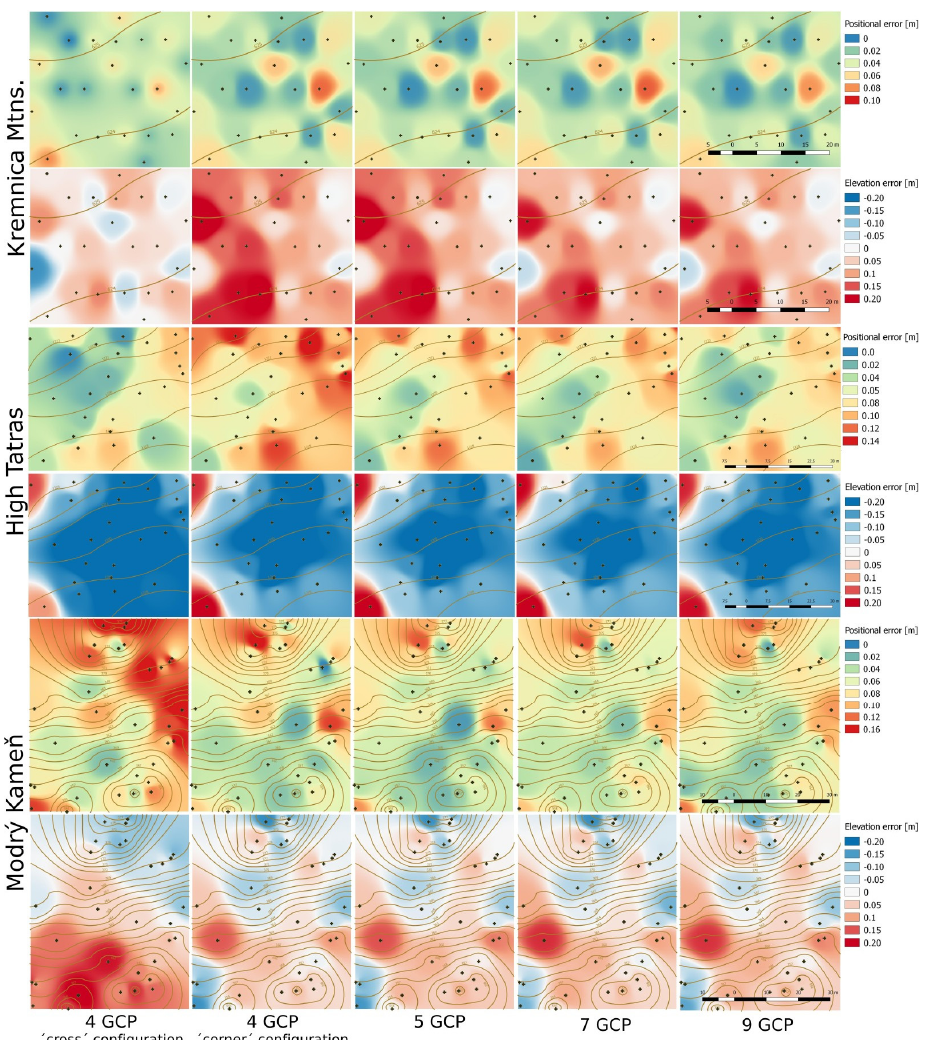
Figure 5. Spatial distribution of horizontal and vertical errors according to test site and GCP configuration. Only errors at the checkpoints (marked) were used for the interpolation.